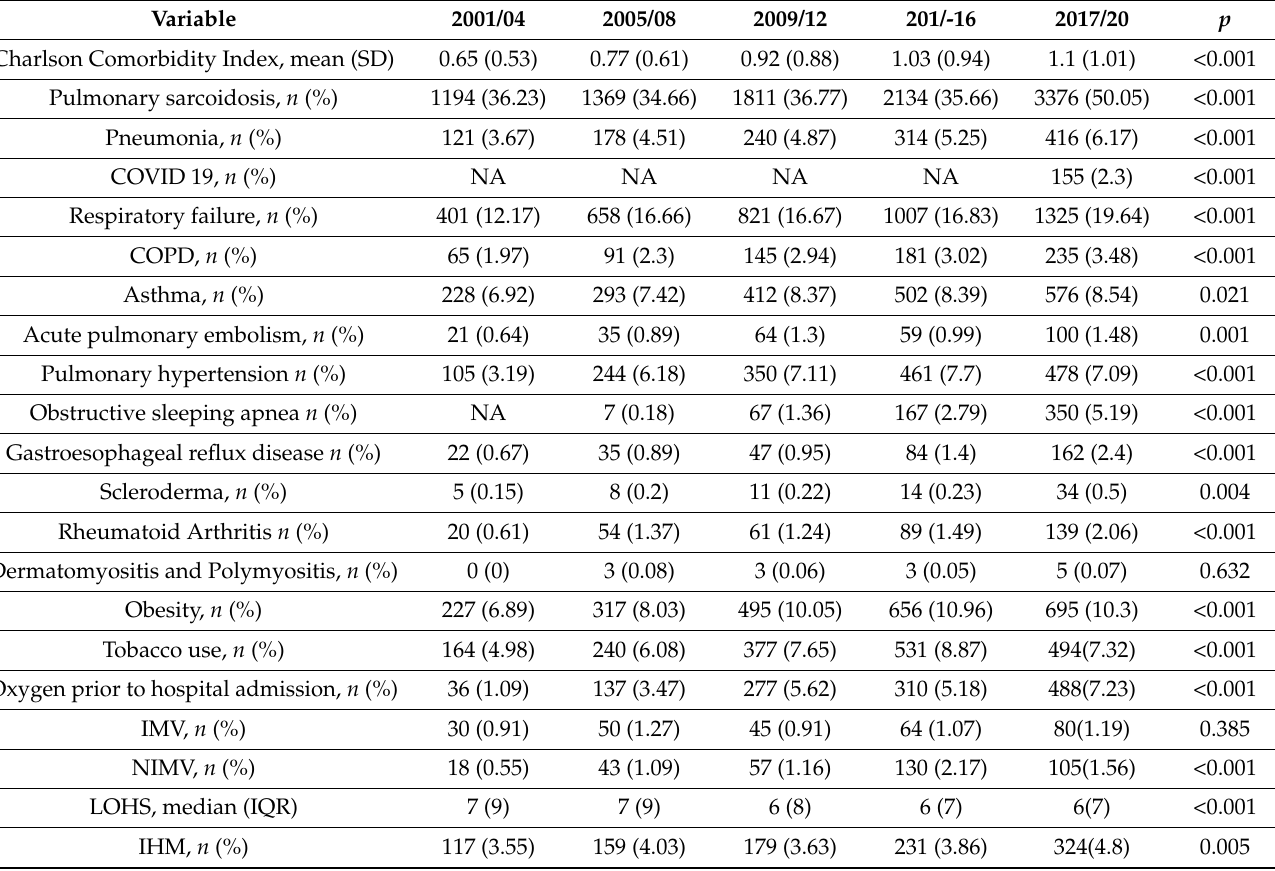
Table 2. Trends in the comorbidities, procedures, and in-hospital outcomes among women hospital- ized with sarcoidosis in Spain from 2001 to